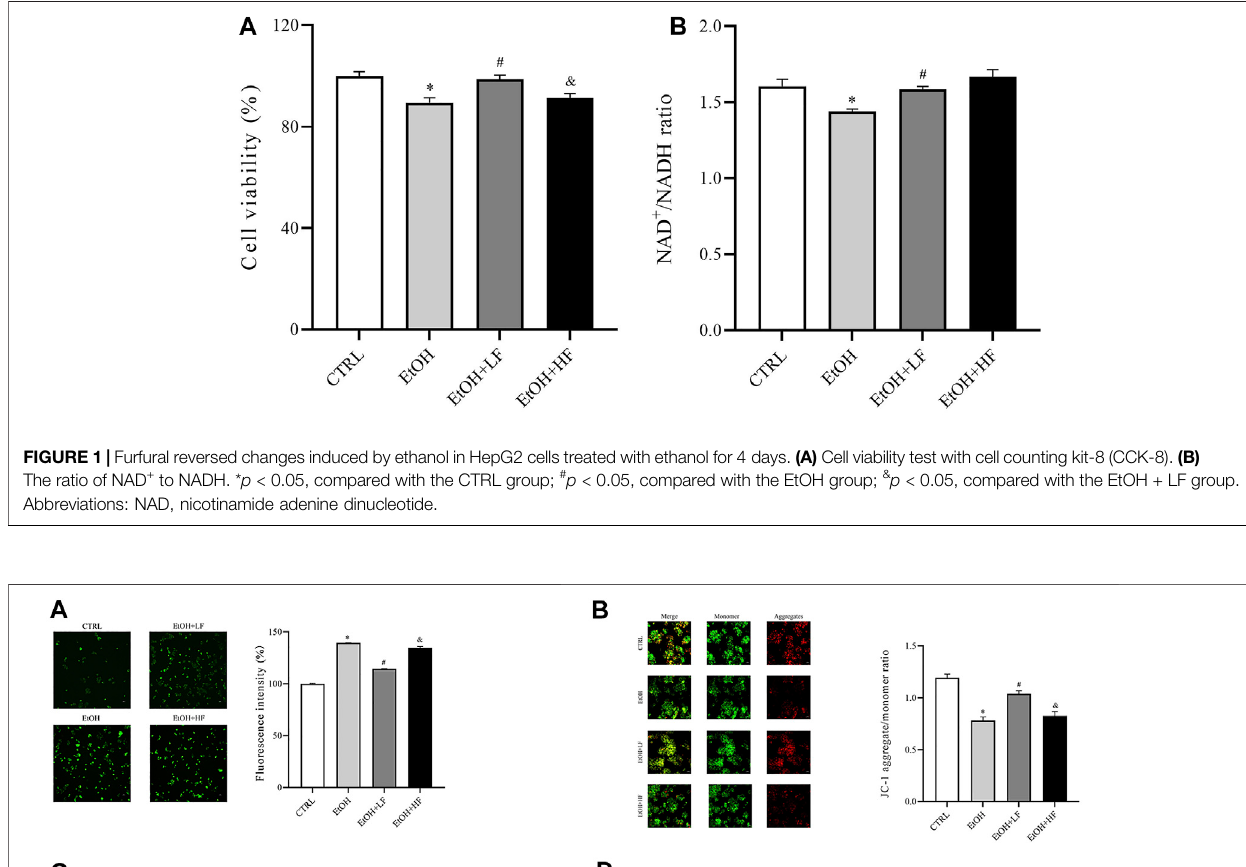
Frontiers in Pharmacology |